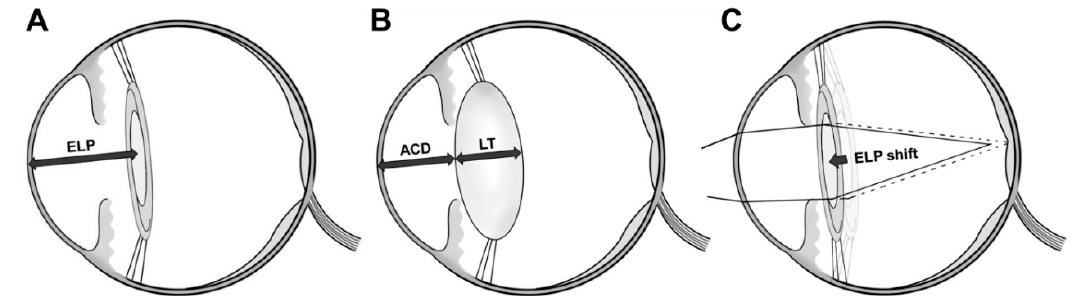
Figure 3. Schematic diagram of changes in postoperative effective lens position (ELP). ( A ): The distance from the corneal apex to the intraocular lens is called the ELP. ( B ): The ELP is affected by anterior chamber depth (ACD) and lens thickness (LT), and the ELP is longer than the ACD and shorter than ACD + LT. ( C ): A shortened ELP results in a shortened focal length and causes a myopic shift.